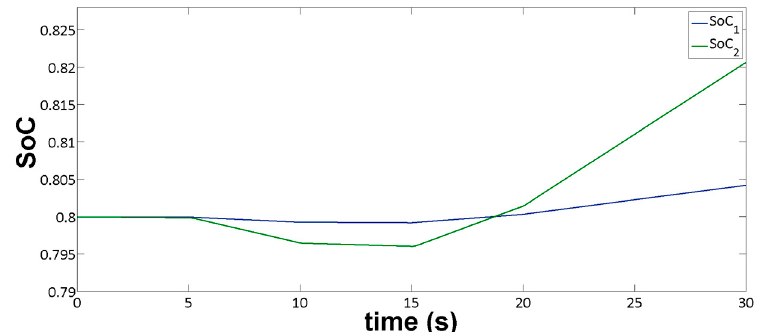
Figure 6. State of charge ( SoC ) of each battery branch.